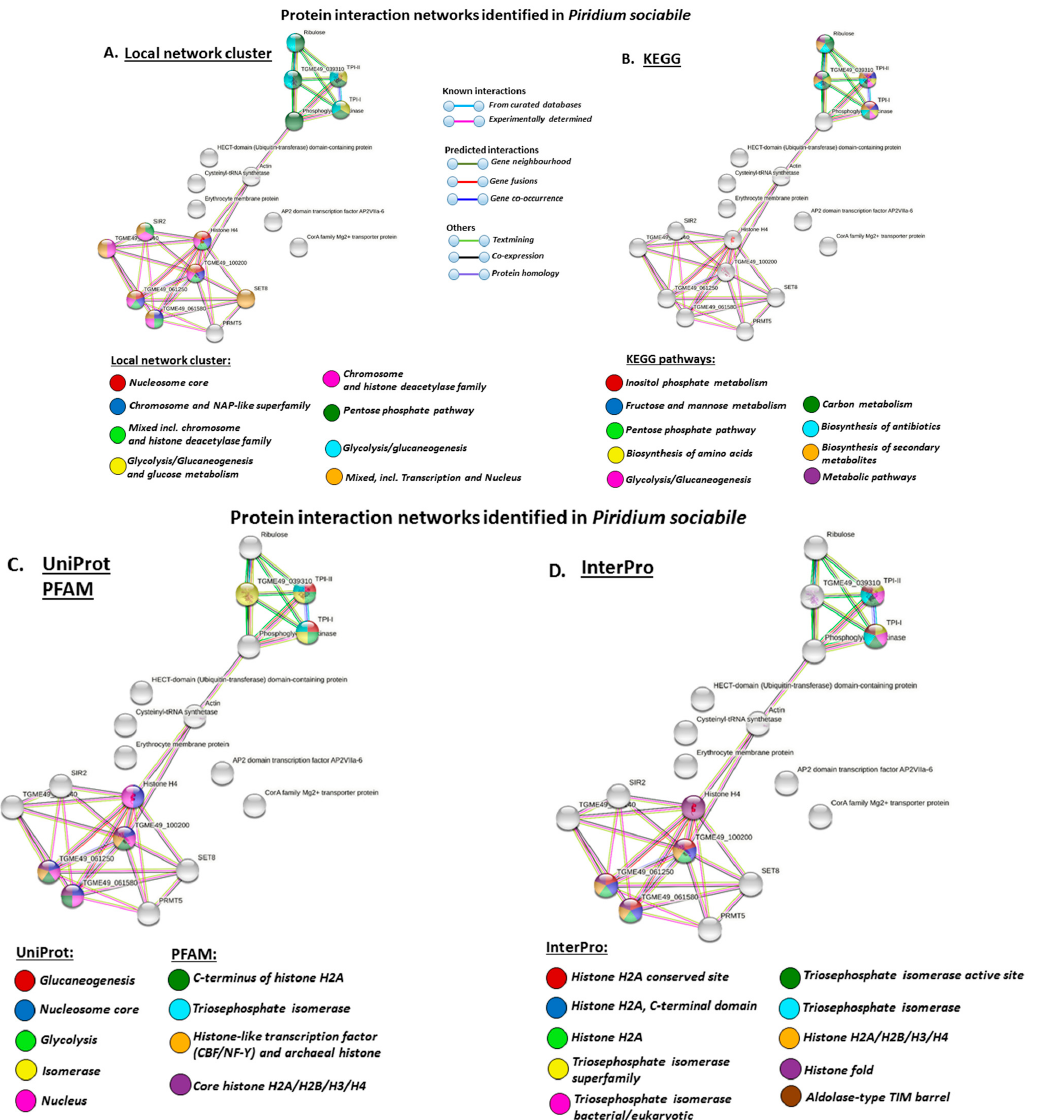
Figure 7. Local Search Tool for the Retrieval of Interacting Genes/Proteins (STRING) network clusters, KEGG pathways and protein domains identified for deiminated proteins in Piridium sociabile . Protein–protein interaction network identified in P. sociabile based on protein identifiers from T. gondii . PPI enrichment p -value: 0.000203. ( A ). Local network clusters are highlighted with the coloured nodes. ( B ). KEGG pathways are highlighted with the coloured nodes. ( C ). UniProt keywords and PFAM protein domains are highlighted with the coloured nodes. ( D ). Protein domains and features are highlighted with the coloured nodes. Colour coding for network nodes and interaction lines is included in the figure.